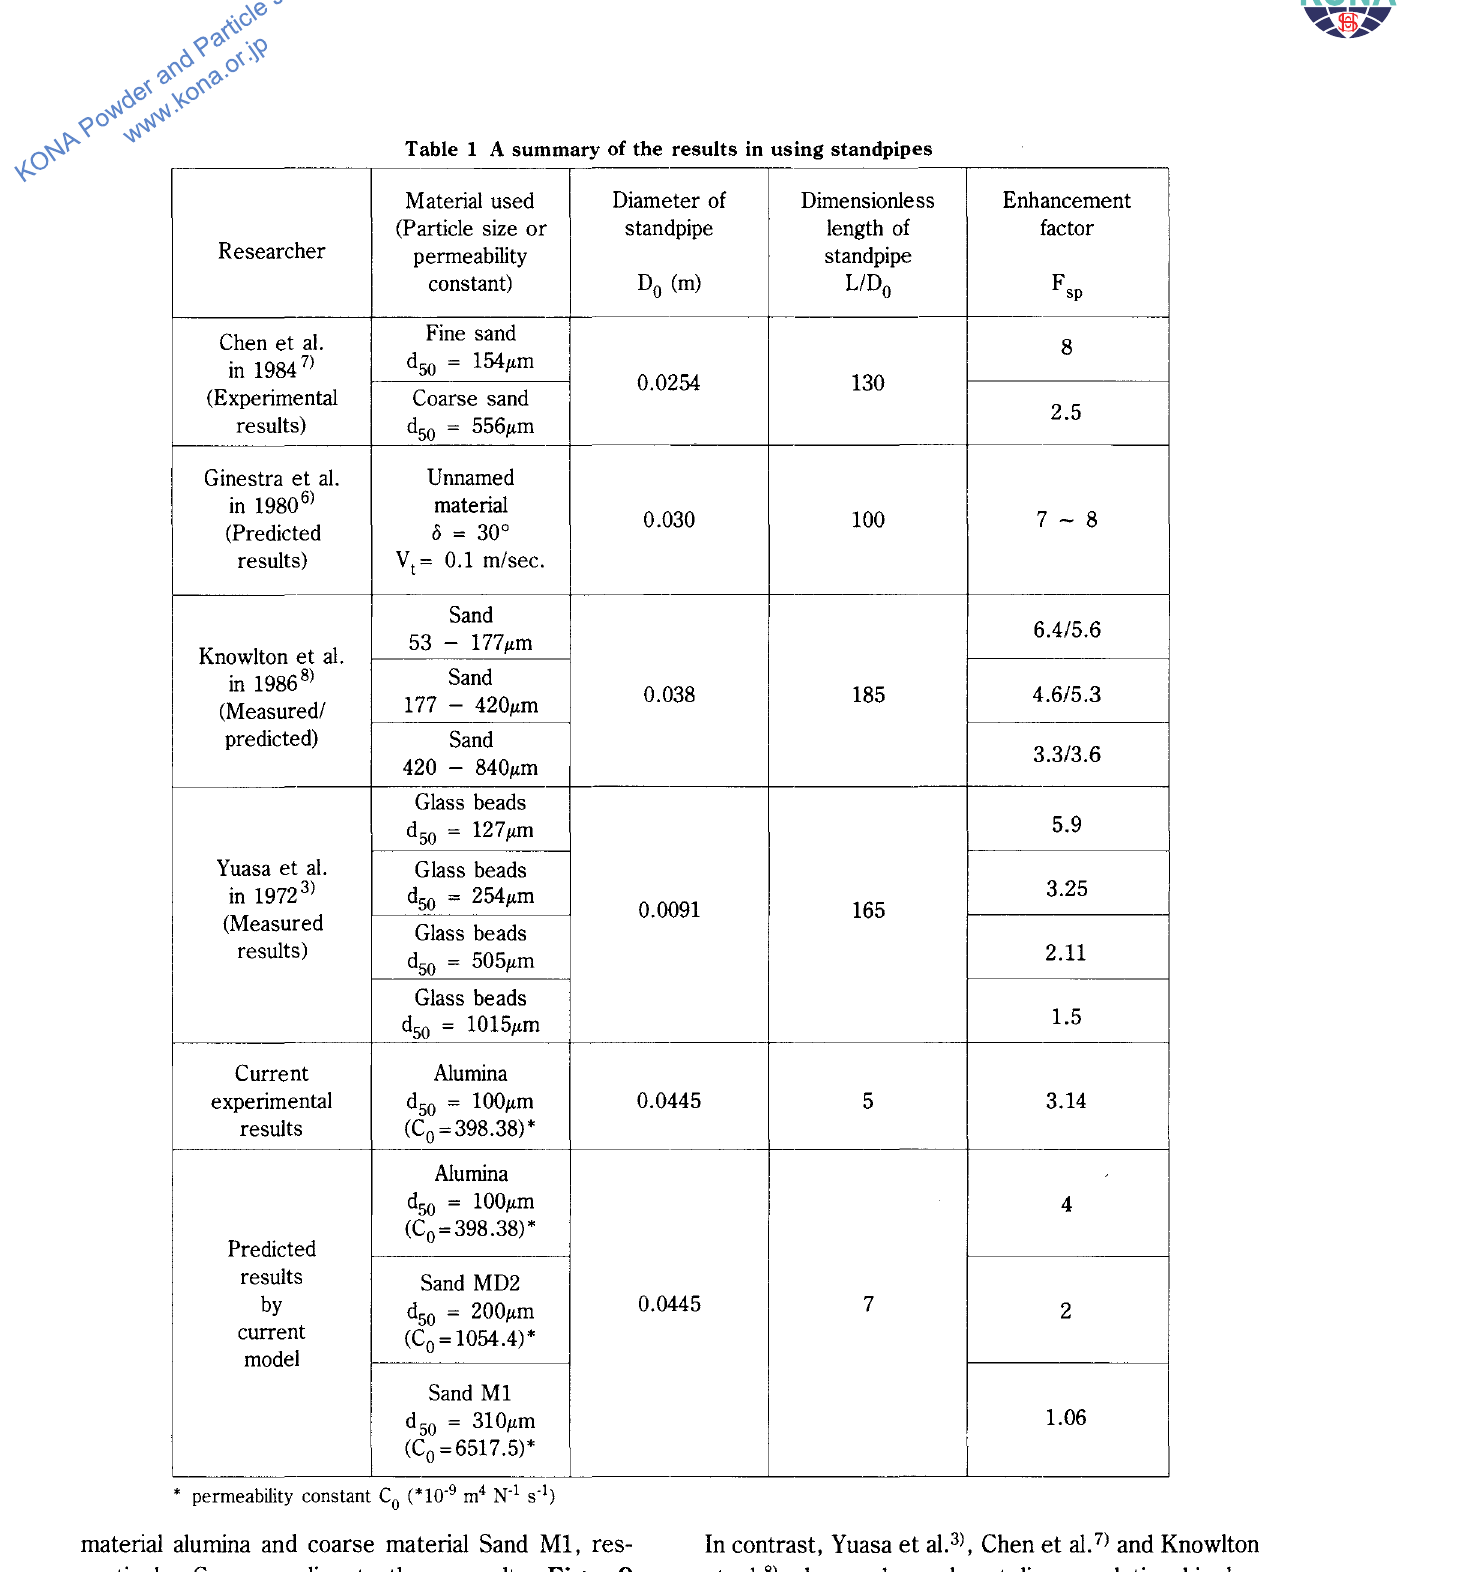
Table 1 A summary of the results in using